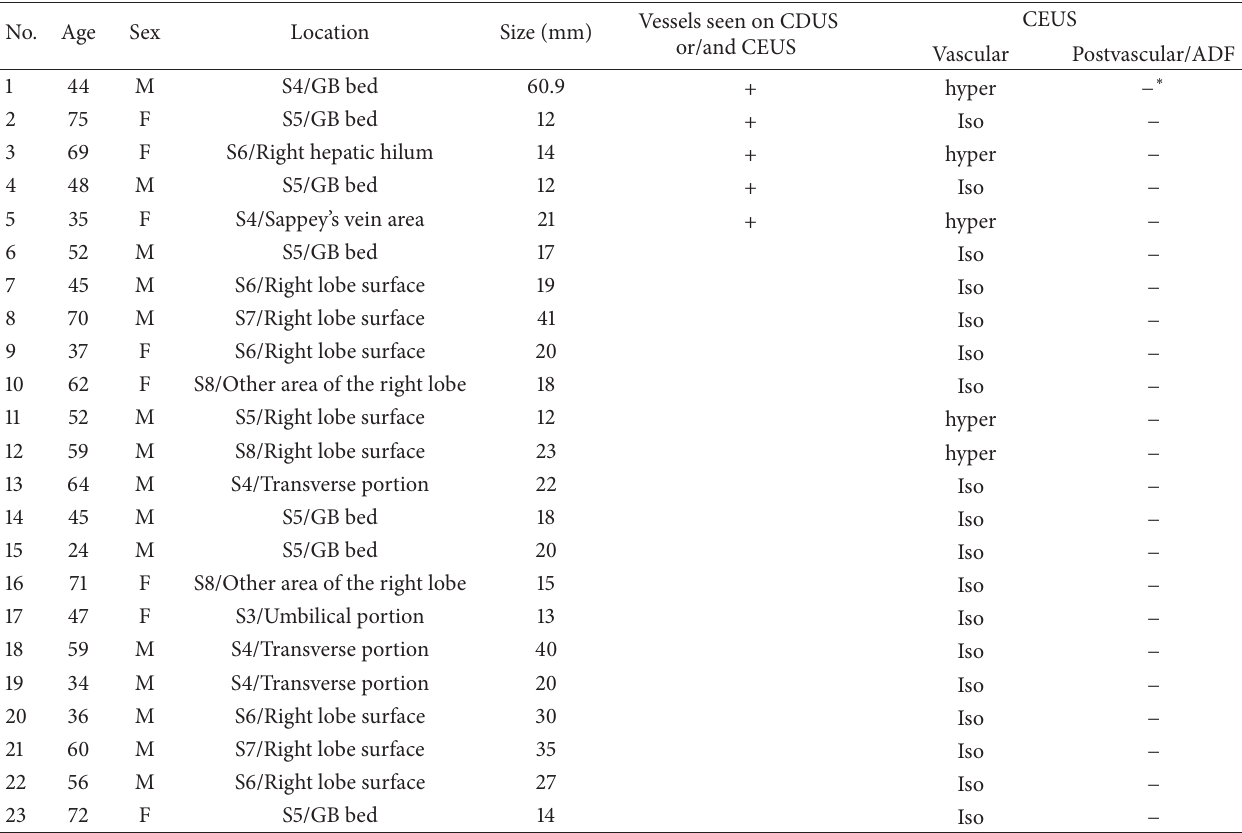
Table 2: Of the 23 lesions with focal spared lesions, patients character, location, size, enhancement pattern in the vascular phase of CEUS, presence of existing blood vessel in the CDUS and/or the vascular phase, presence of hypoechoic area in the postvascular phase, and ADF mode of